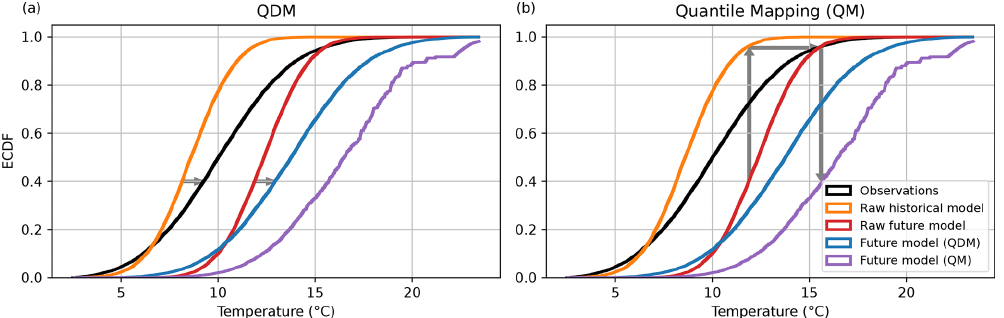
Figure 3. Schematic of bias adjustment for temperature data. CDFs are shown for following data: observational data (black), raw historical model (orange), raw future model (red), future model corrected with QDM (blue) and future model corrected with QM (purple). The arrows illustrate the bias-adjustment path for future model data. Panel (a) shows QDM, where the model bias in the calibration period (left arrow) is applied to the future model data (right arrow that has the same length as the left arrow). Panel (b) shows QM, where the correction value is found at the model bias in the historical period of the same absolute